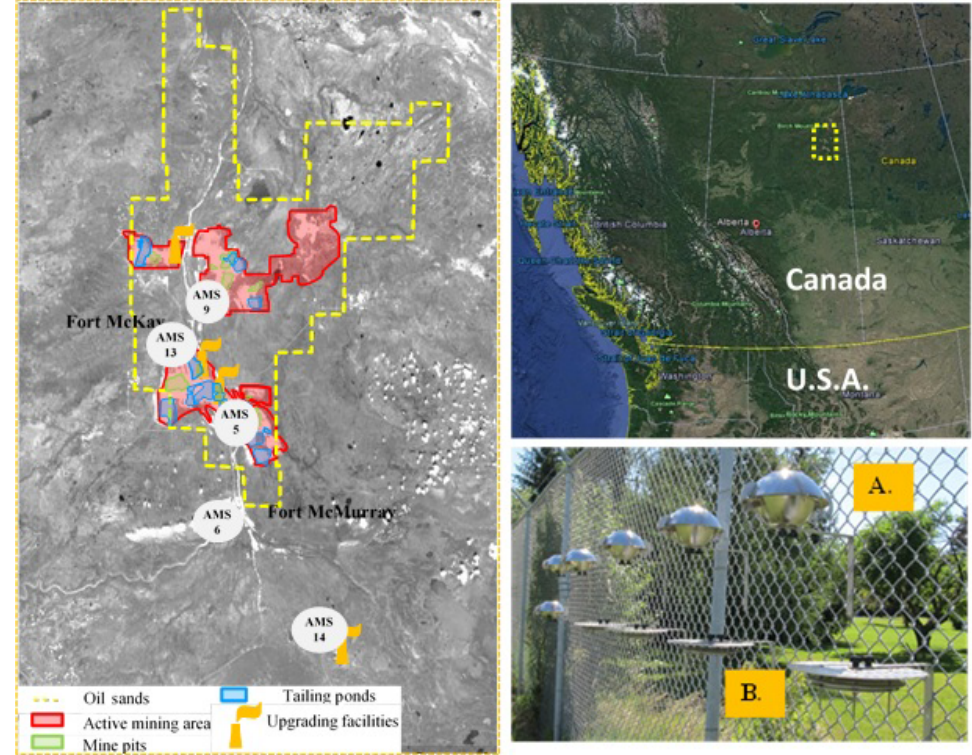
Figure 1. Passive sampling site map (110km × 180km). AMS5 – Mannix, AMS6 – Fort McMurray, AMS9 – Barge landing, AMS13 – Syncrude, AMS14 – Anzac. (a) Conventional PUF disk passive air samplers (PAS) and (b) passive dry deposition sampler